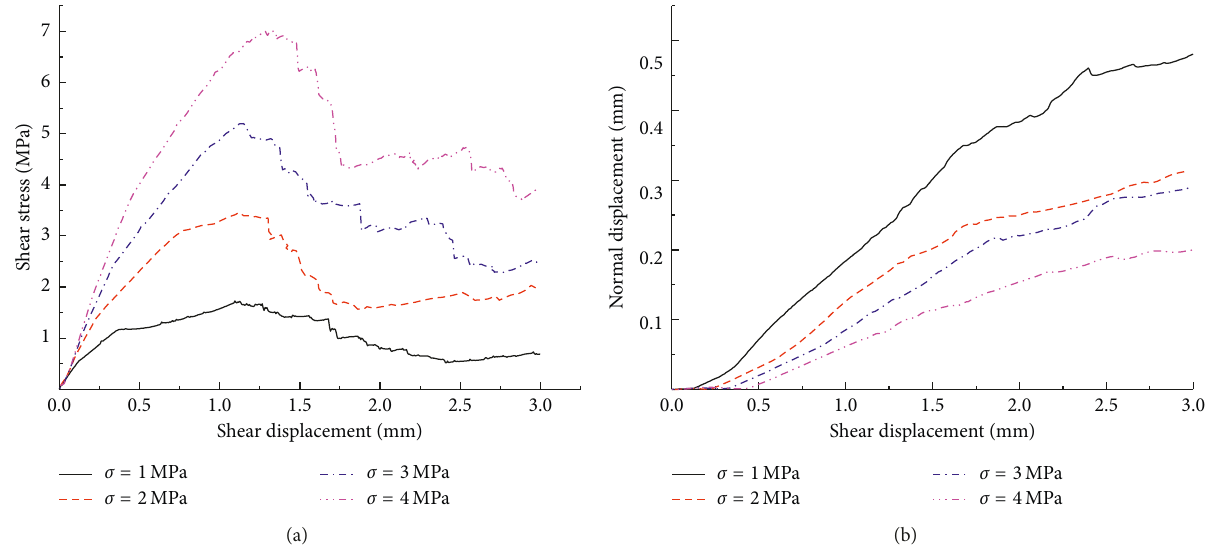
Figure 14: Results for a sawtooth joint with an inclination angle of 30 ° . Curves of (a) the shear stress and displacement and (b) the normal and shear displacement.